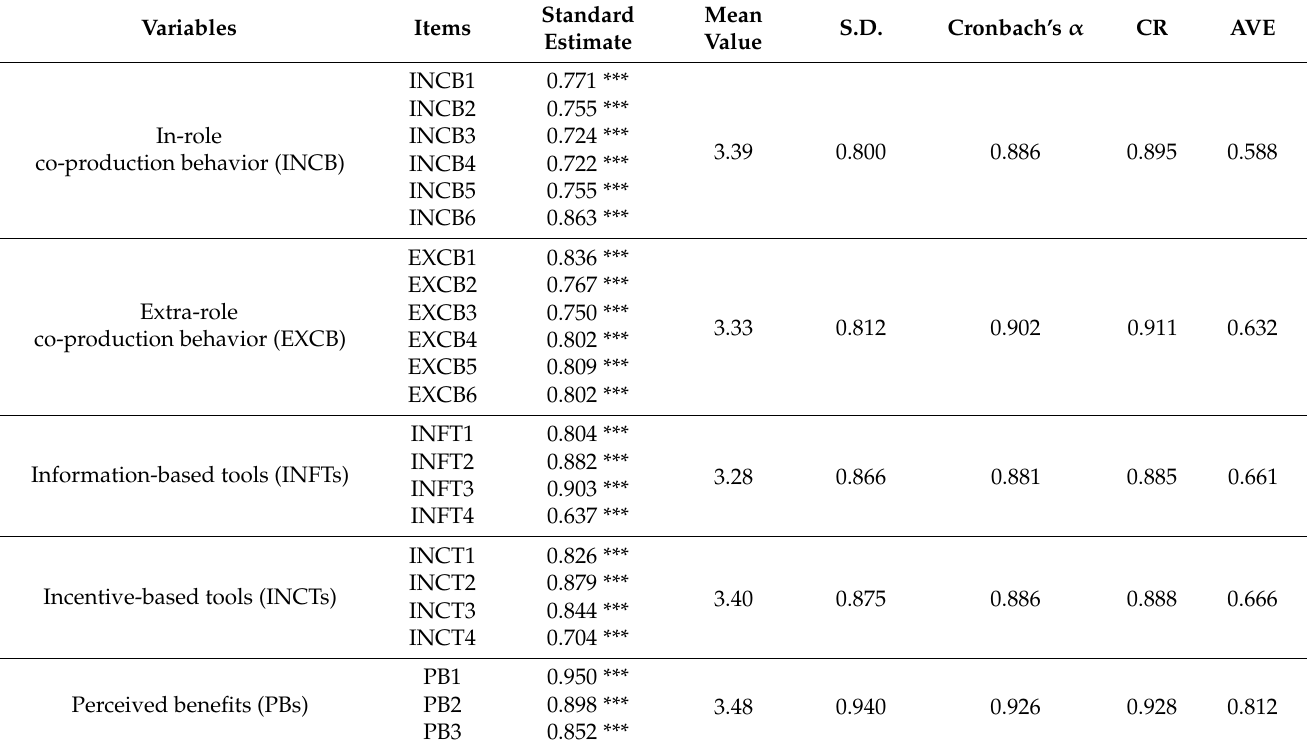
Table 2. Descriptive statistics and reliability and validity statistics.